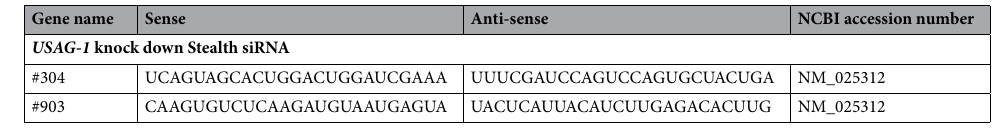
Table 1. Sequences of Usag-1 siRNAs.